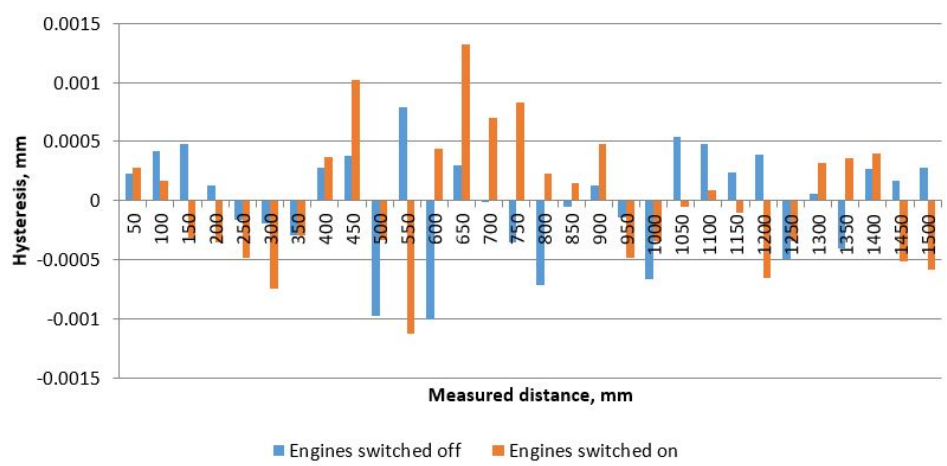
Figure 4. Hysteresis error for measurements with motors turned off and on.